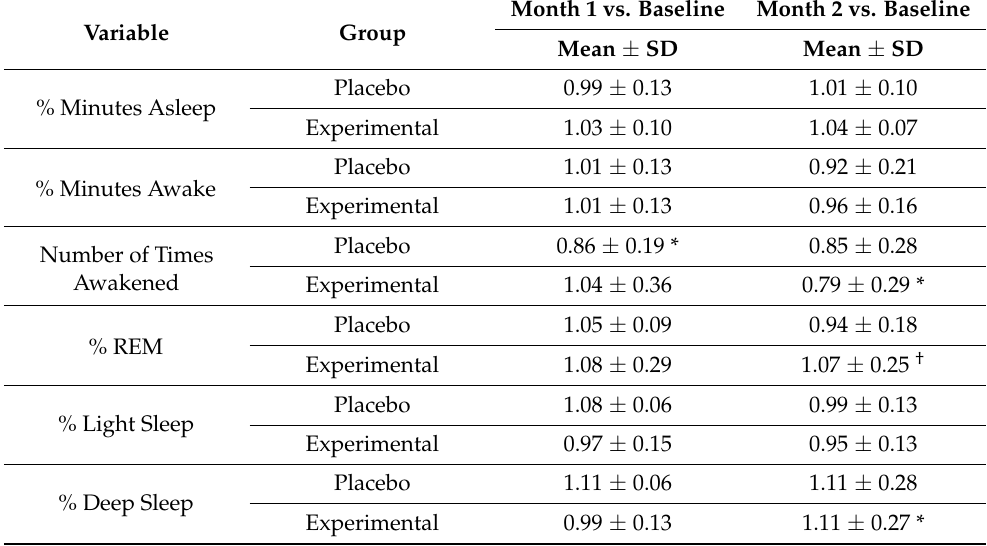
Table 9. Results of Fitbit data. Change vs. baseline = percent change from